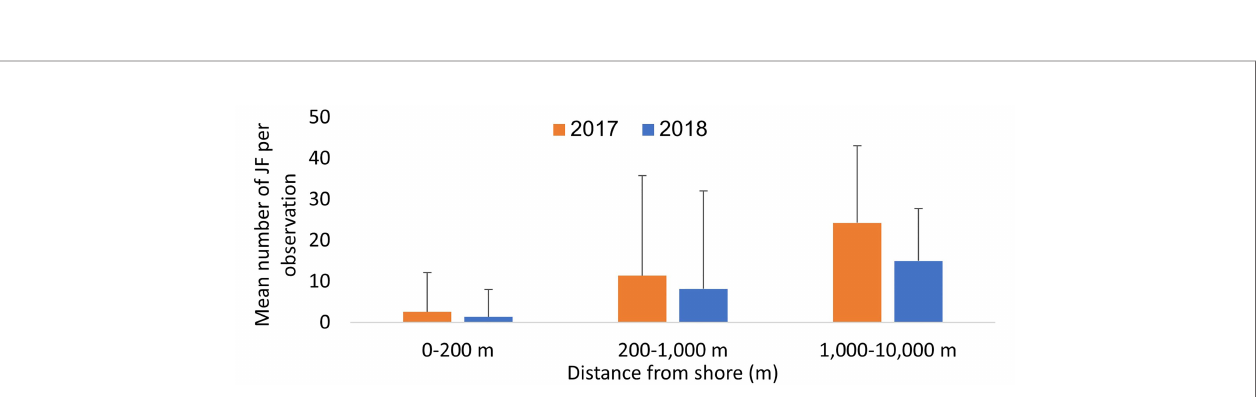
FIGURE 2 | Weekly Jelly fi sh Swarm Index (JSI) in Tel Aviv and Haifa beaches in the summers of 2017 and 2018 (A) , and total number of R. nomadica reported per week, ranked by size (bell diameter) distribution (B) .